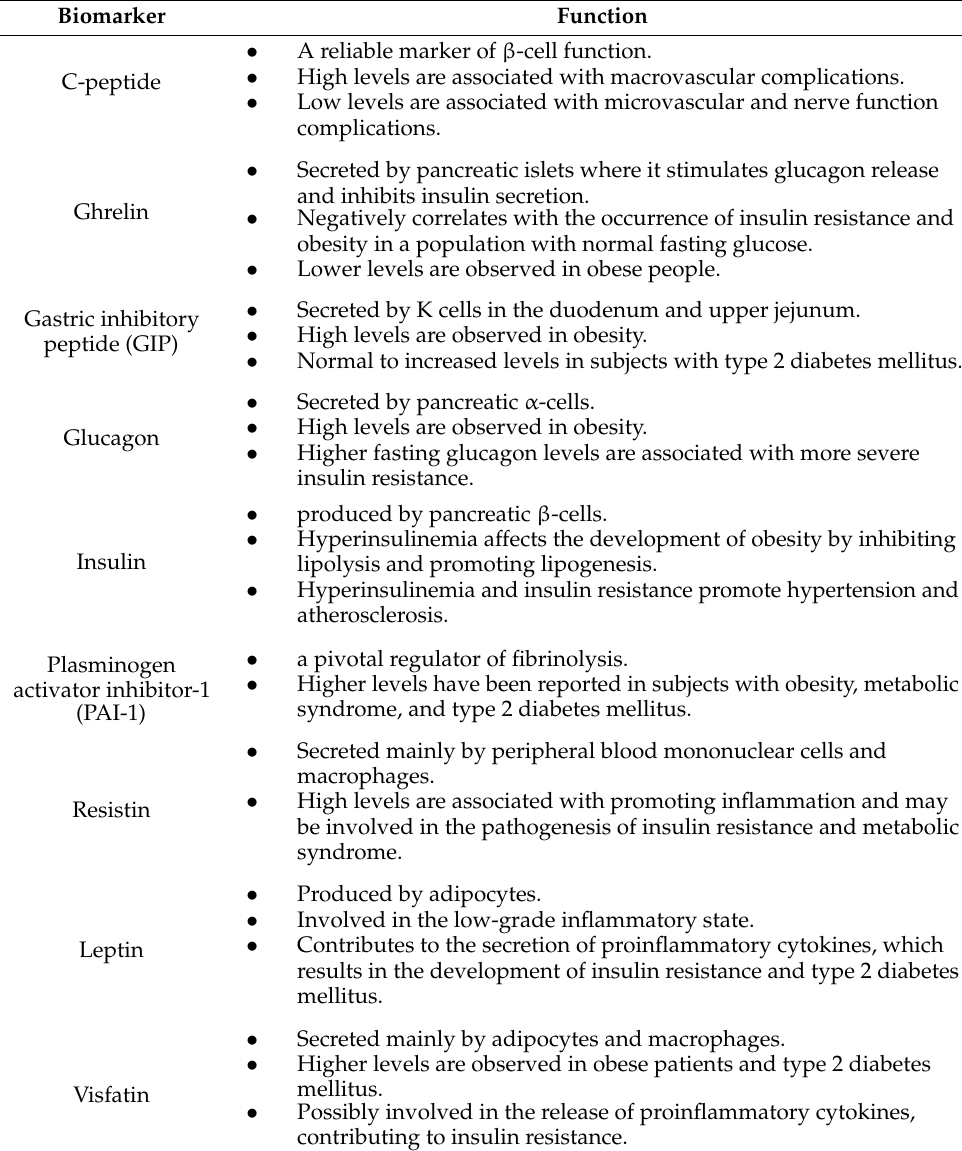
Table 1. Descriptive characteristics of diabetes markers